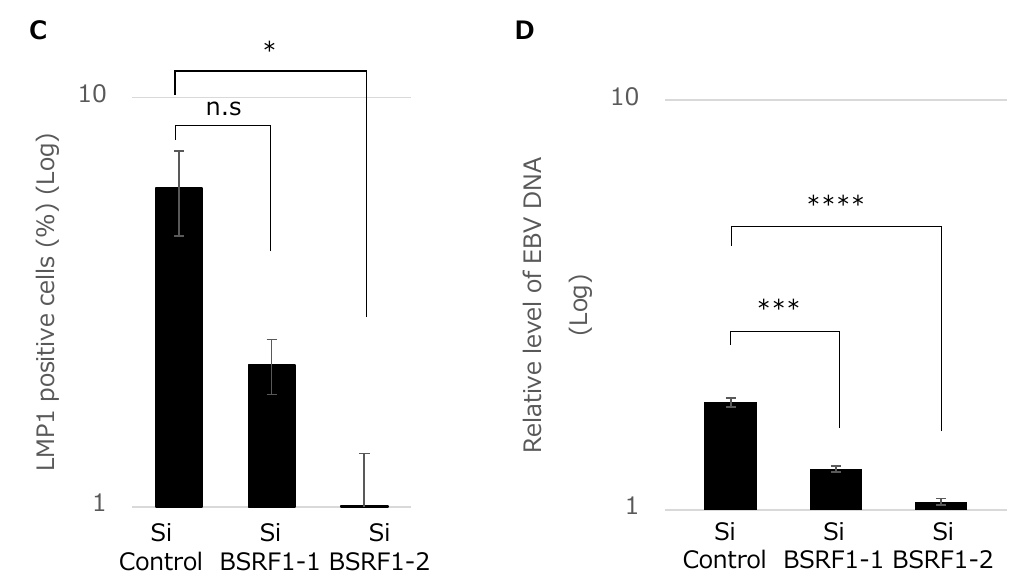
Figure 4. Knockdown of BSRF1 decreased progeny production. ( A ) Effect of BSRF1 knockdown on viral lytic protein expression in B95-8 cells. B95-8 cells were transfected by electroporation with two independent siRNAs (siBSRF1-1 and -2) or control siRNA and incubated. Cells were harvested after 3 days and subjected to immunoblotting with the indicated antibodies. ( B , C ) Infectivity of the progeny virus particles produced from B95-8. Six days after the transfection of siRNA as in (A), progeny virus produced into the media was inoculated with Akata( − ) cells for 2 days, followed by immunofluorescence assay by using anti-LMP1 antibody (B). Percentage of green fluorescence-positive cells over total cells is shown in (C). Production of progeny in the culture media. B95-8 cells were transfected and cultured as in (B). ( D ) The medium was collected after centrifugation, treated with DNase, and subjected to DNA extraction and quantification by qPCR. The means ± SD of three independent biological replicates are shown. n.s, not significant.; *, P < 0.05; ***, P <